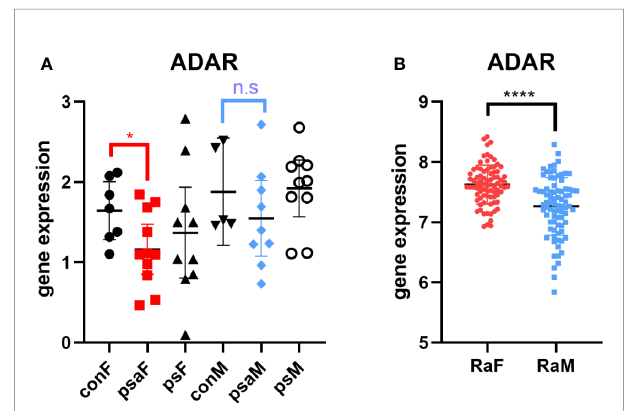
FIGURE 4 | Expression of ADAR in RA or PsA from GEO datasets GSE61281 (A) and GSE74143 (B) . con, control; psa, psoriatic arthritis; ps, psoriasis; RA, rheumatoid arthritis; F, female; M, male. Data from all bar graphs are presented as mean ± SEM. (*P < 0.05, ****P < 0.0001, n.s, not signi fi